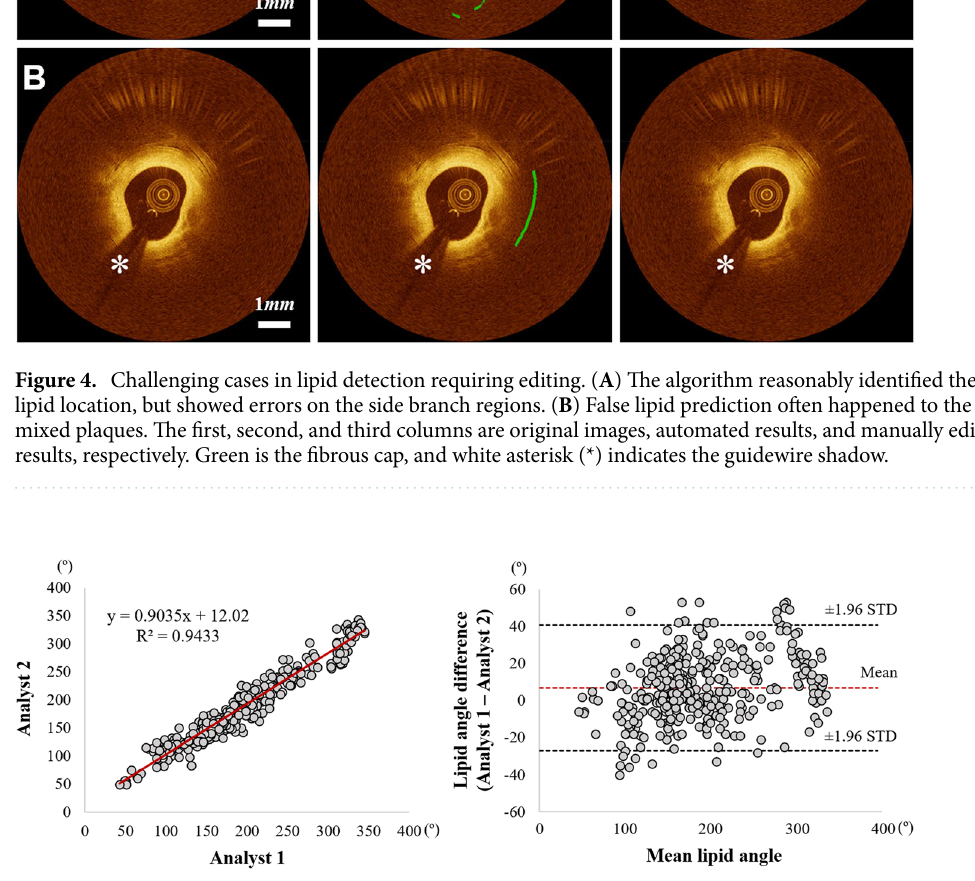
Figure 5. Inter-observer variability test of lipid angle between two analysts after automated prediction + manual editing. Panels are (left) linear regression plot and (right) Bland–Altman plot. The R-squared (R 2 ) value was 0.943 (left), and the mean bias between two analysts was 6.7° ± 17.3°